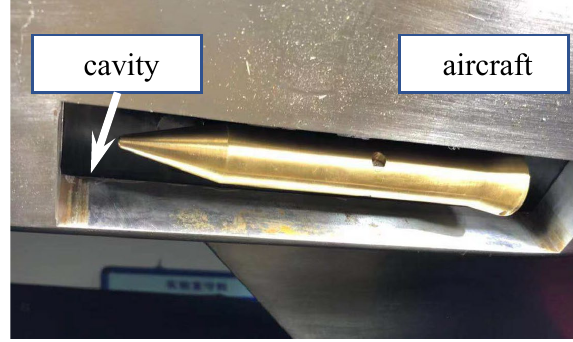
Figure 4. Test cavity.